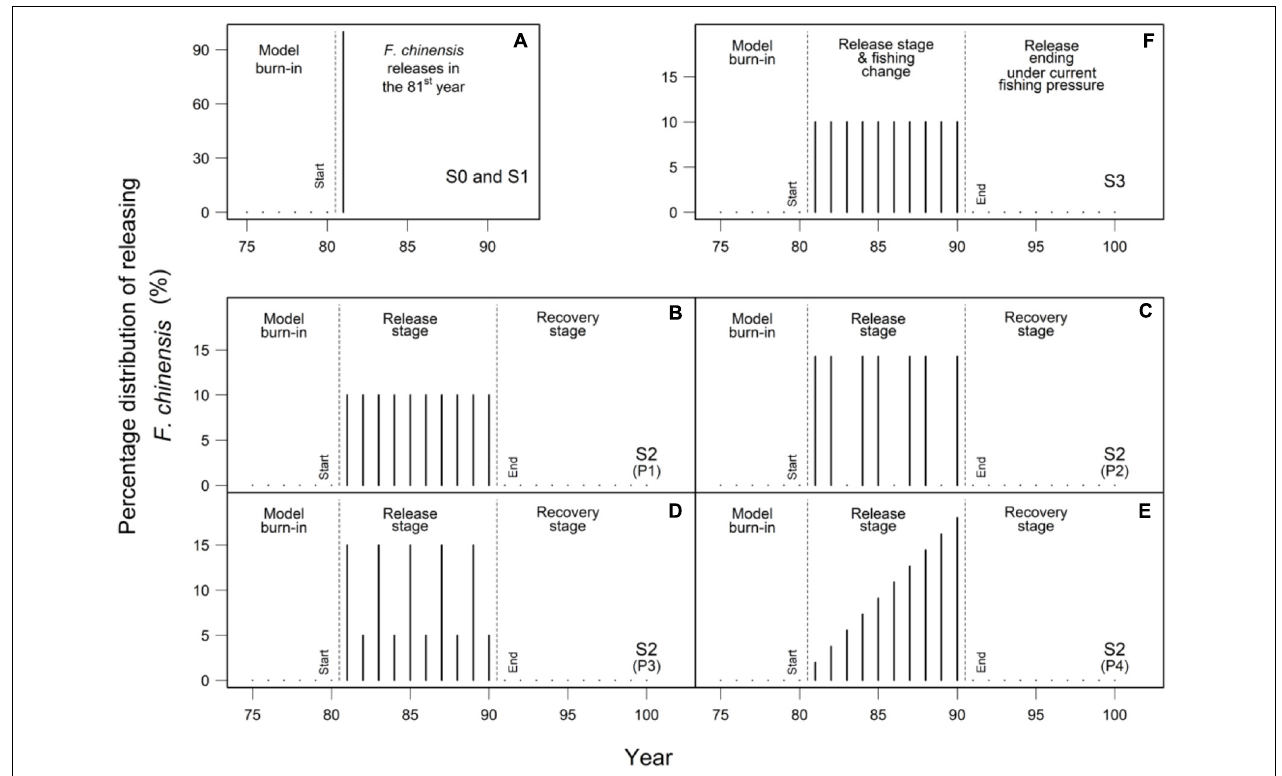
FIGURE 2 | Percentage distribution of releasing F. chinensis in the scenarios S0 and S1 (A) , S2 (B–E) , and S3 (F) . The sum of percentages in the release stage was equal to 100%.